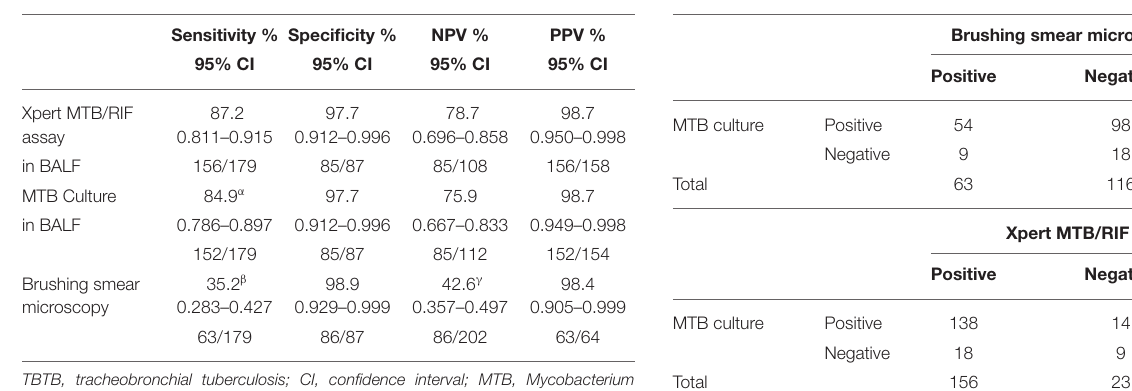
TABLE 2 | Diagnostic efficacy of the different diagnostic methods for TBTB patients.